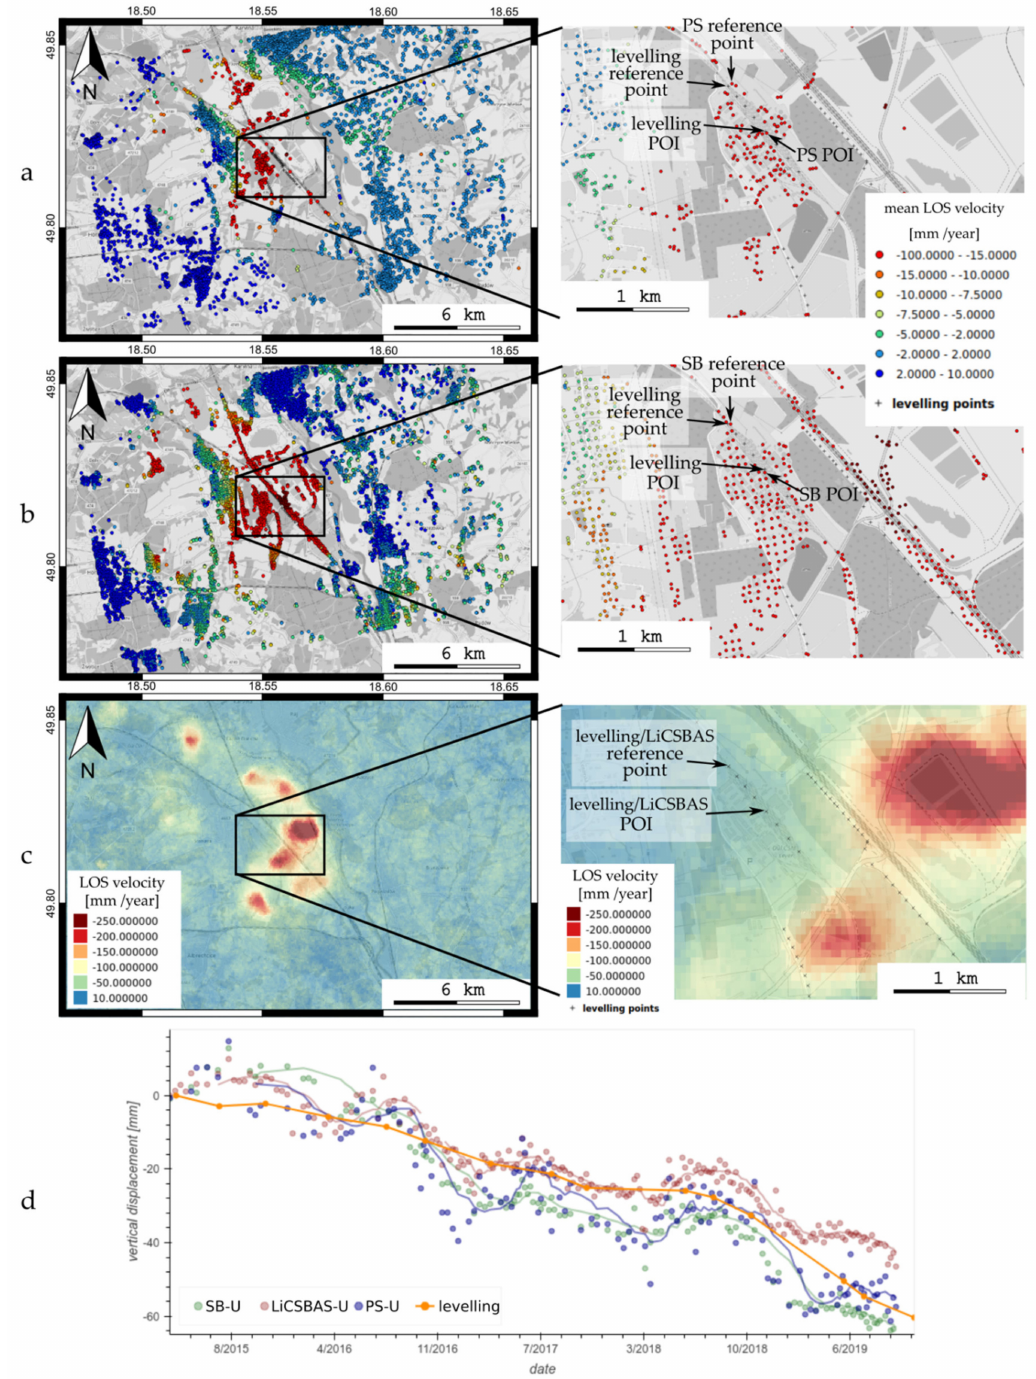
Figure 8. Mean LOS velocity estimated from burst ID 175_2_8091 (220 SLC C images, February 2015–September 2019) using ( a ) STAMPS PS, ( b ) STAMPS SB, ( c ) LiCSBAS NSBAS; ( d ) comparison of measurements of point of interest (POI) from ( a – c ) recomputed to vertical direction (U) and levelling